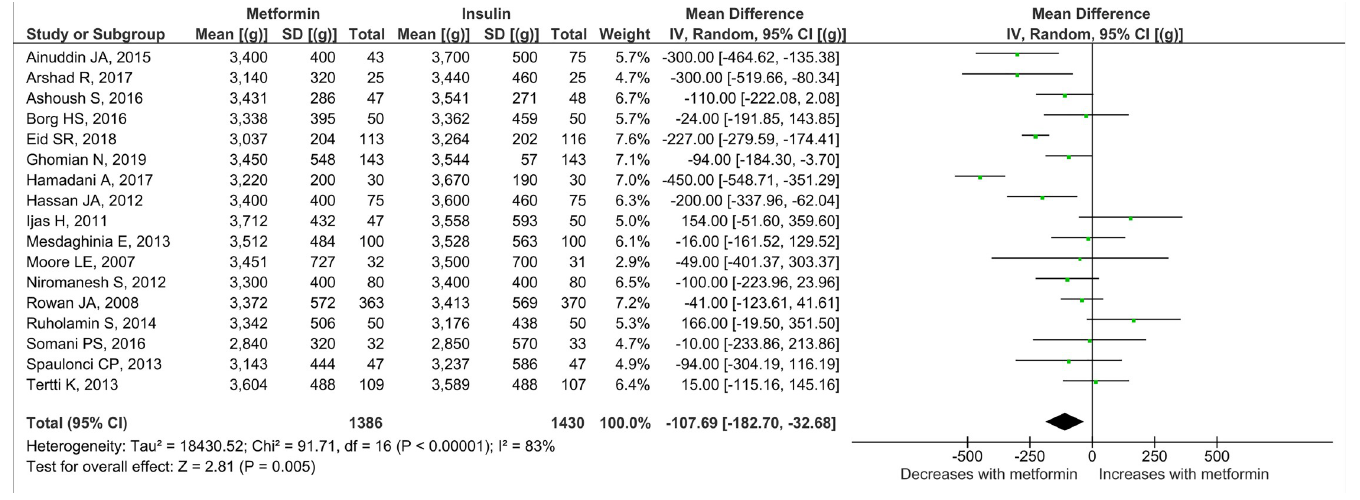
Fig 2. Birth weight. Expressed as mean difference (random effects model). IV, mean difference.